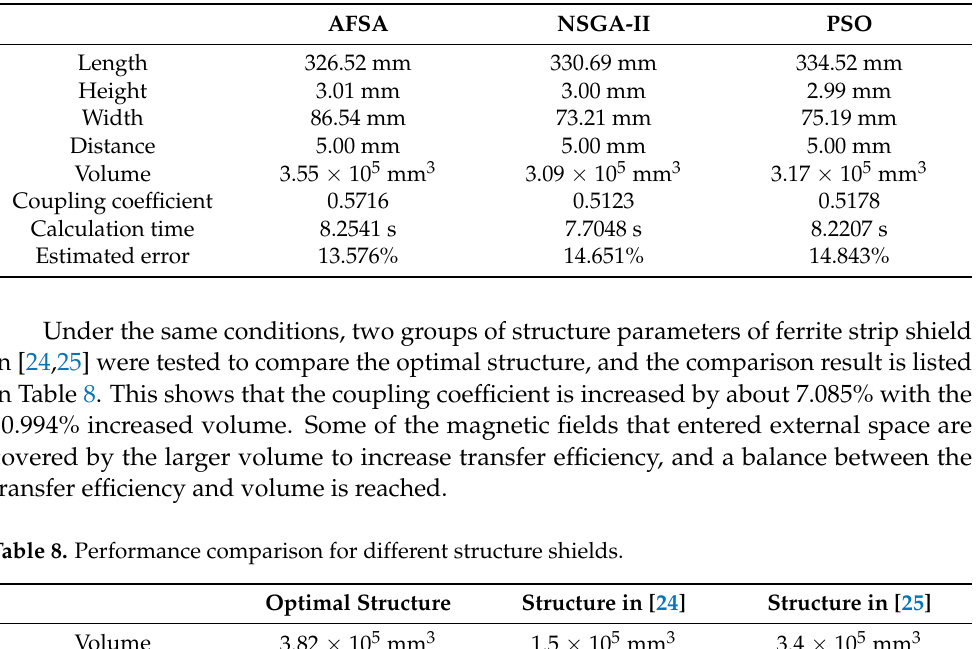
Table 7. Performance comparison for different optimization methods.